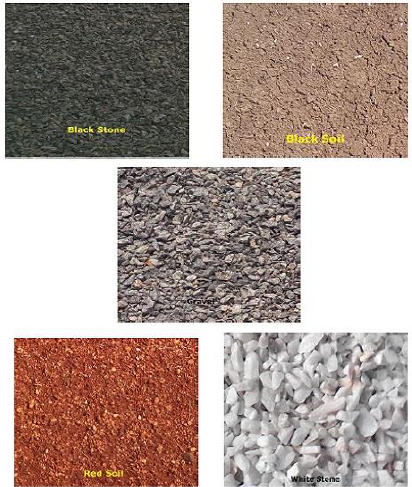
Figure 4. Five natural target